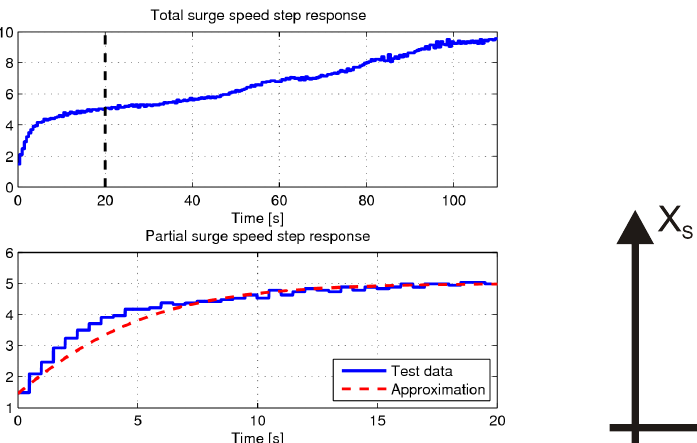
Figure 10: A polar coordinate decomposition of the ve- locity error ˜v (  ) into a speed error ˜  and a course error ˜ 